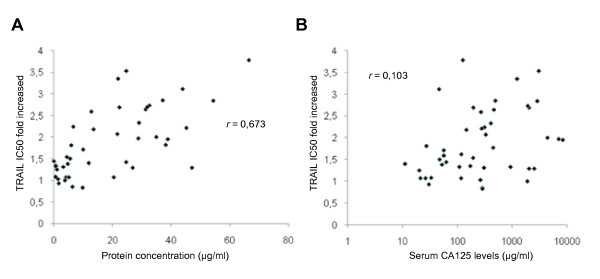
Protein concentration of peritoneal fluids and baseline serum CA125 levels. (a) Protein concentration of the 44 ovarian cancer ascites was determined and correlated with TRAIL IC50 fold increased mediated by ascites. (b) Baseline serum CA125 levels were obtained for all except one patient and correlated with TRAIL IC50 fold increased mediated by ascites. Correlation coefficients (r) were determined by Pearson's correlation coefficient test.